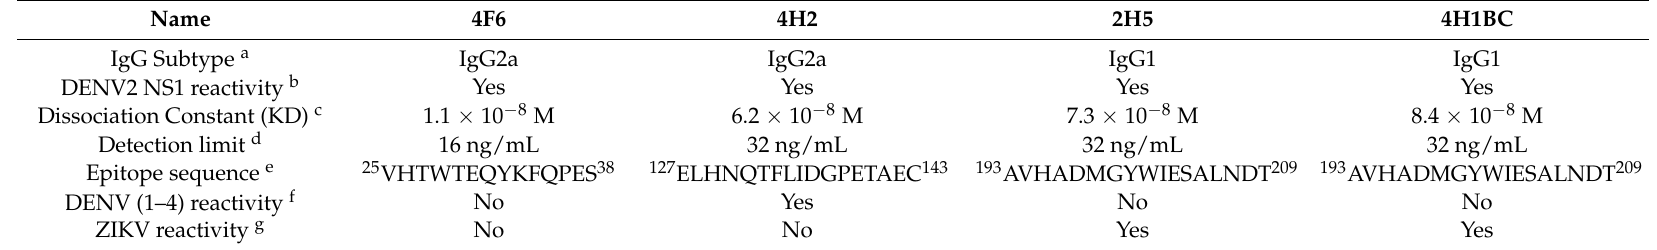
Table 1. Characteristics of the monoclonal antibodies (mAbs) against dengue virus (DENV) nonstructural protein 1